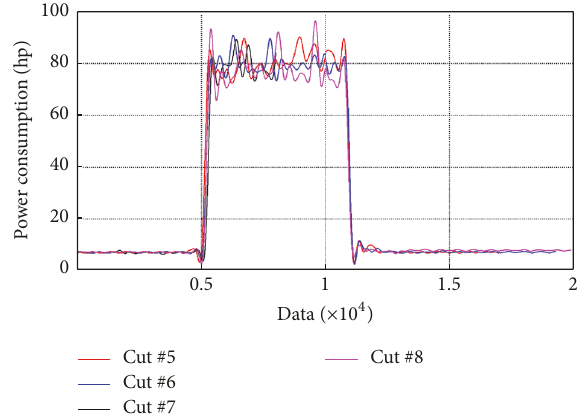
Figure 5: Measured power consumption during cutting, tests at 2800 rpm.